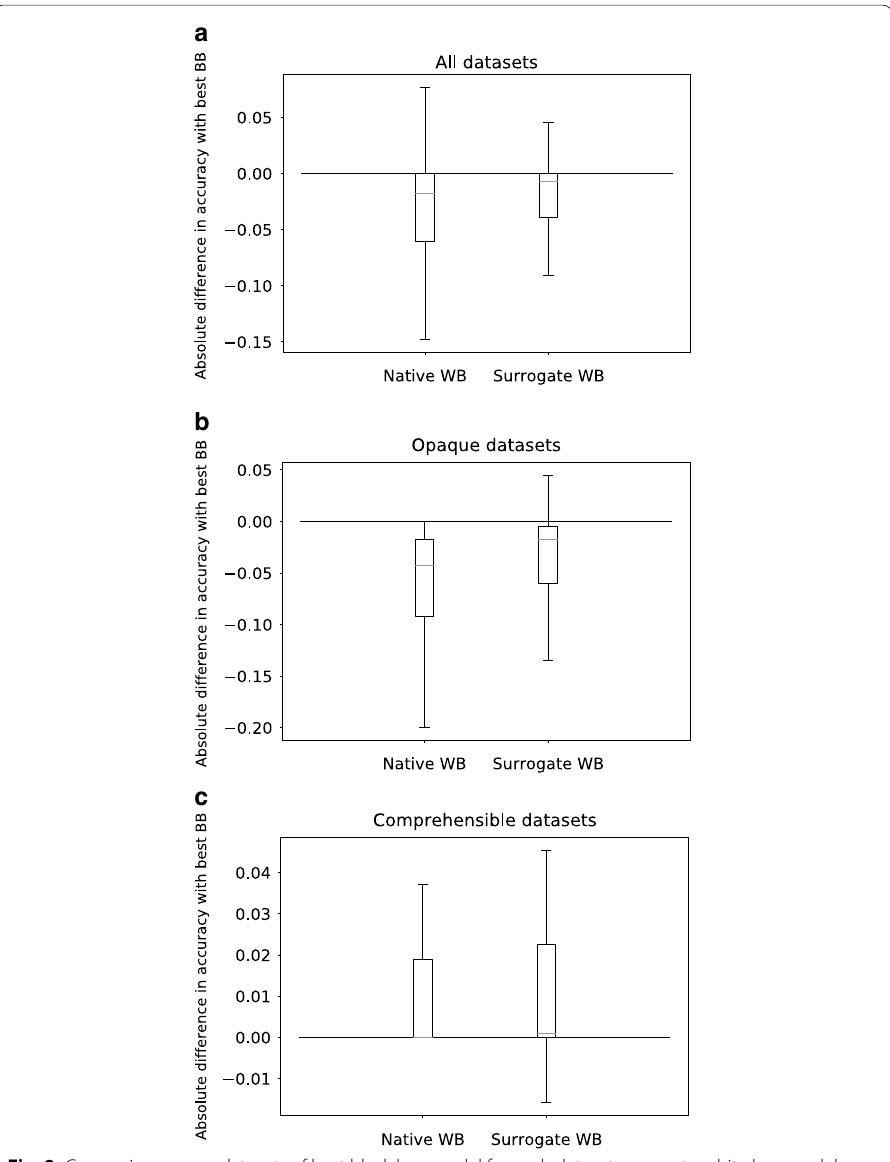
Fig. 8 Comparison across datasets of best black box model for each dataset, surrogate white box model mimicking this best black box, and best native white box model. BB stands for black box and WB for white box. The line at 0 indicates the performance of the best black box model. The y-axis indicates the absolute difference in accuracy from the best black box